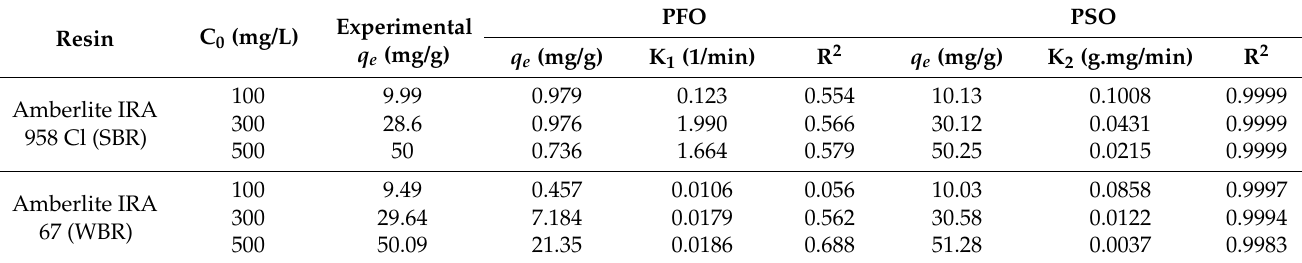
Table 5. Kinetic parameters for adsorption of Direct Yellow RL on IER using the pseudo first order and pseudo second order.